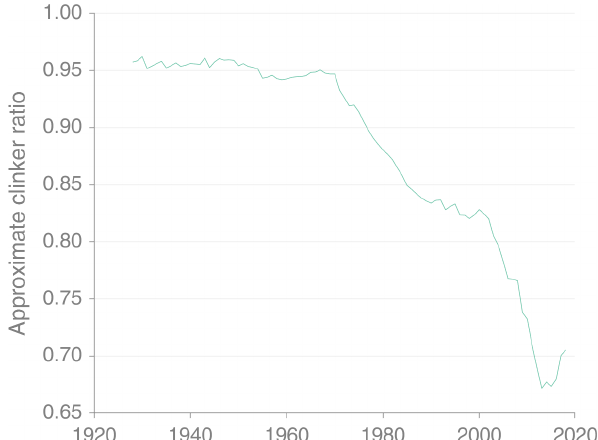
Figure A1. Approximate implied global clinker ratio, derived from emissions estimates and cement production data using default emis- sion factors. The trend up until 1990 is largely a result of the as- sumptions used in extrapolation, although in earlier years the data for the US and Europe